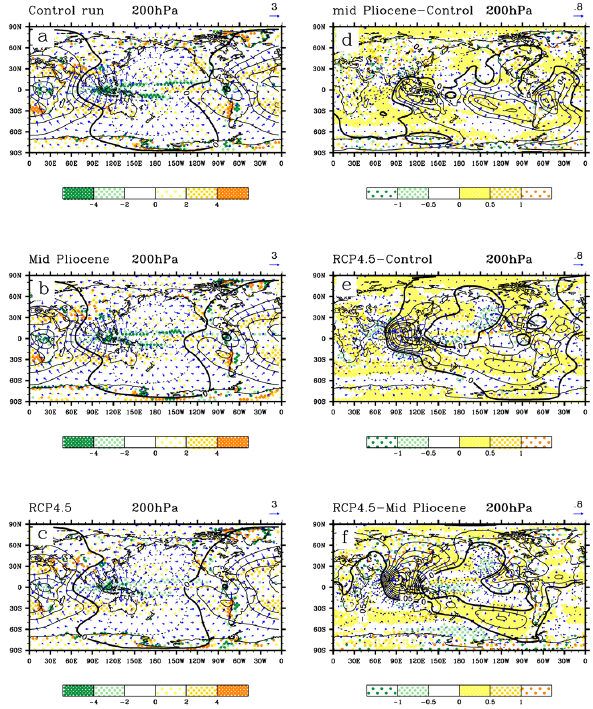
10 7 m 2 s − 1 ) and divergent wind (blue vectors; ms − 1 ) at 200hPa height, as well as vertically averaged vertical wind ( ω , 10 − 2 ms − 1 ) weighted by the level’s pressure depth (shaded dot region), derived from different simulations: (a) pre-industrial control run; (b) mid- Pliocene warm period; and (c) the RCP4.5 scenario. The response of multi-variables (potential velocity, divergent wind, ω ) to the future and mid-Pliocene warming when compared to control run are dis- played in (d, e) , and (f) represents differences between the RCP4.5 scenario and